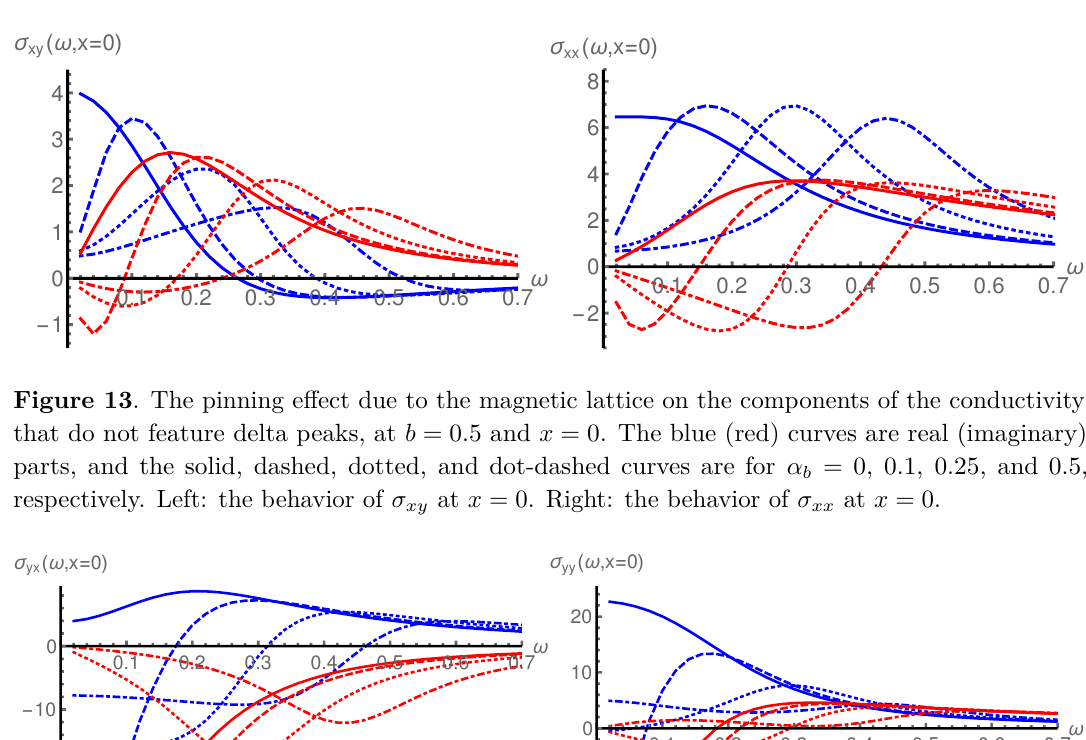
higher frequencies just as in [39]. The peak also broadens and shrinks, as the corresponding pole moves further off the real